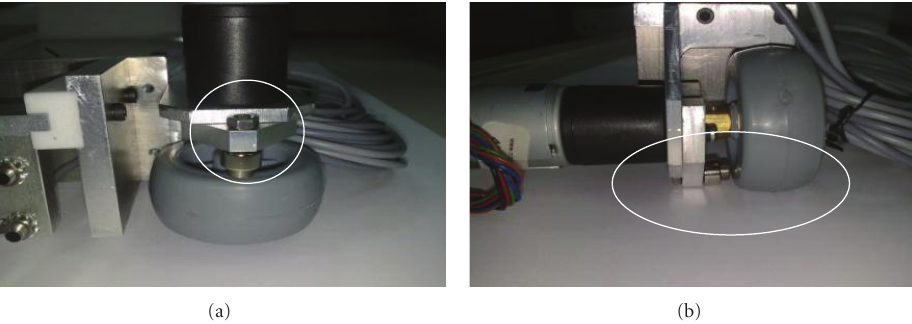
Figure 5: Locomotion system aided with a small rotational circular permanent magnet.